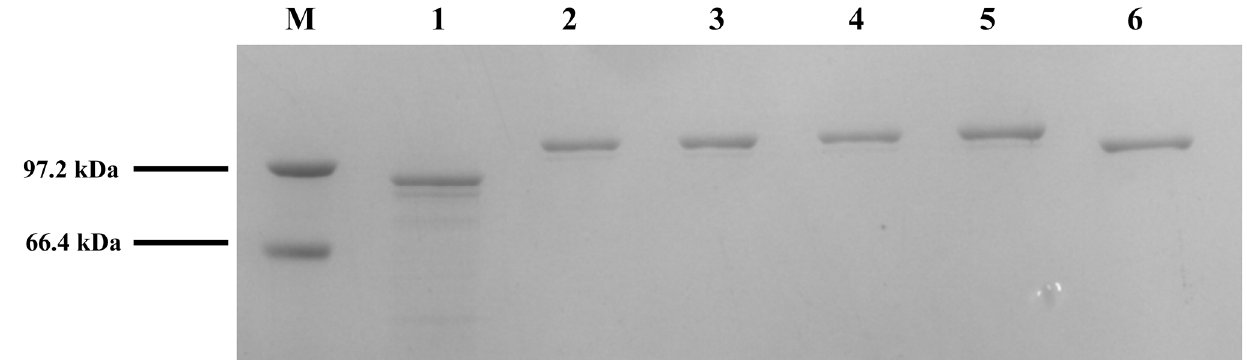
Figure 4. SDS-PAGE analysis of cyclized AGL. Lane M, protein marker; Lane 1, Control (wild type AGL); Lane 2, RIAD-AGL-RIDD; Lane 3, SpyTag-AGL-SpyCatcher; Lane 4, SnoopTag-AGL-SnoopCatcher; Lane 5, SdyTag-AGL-SdyCatcher; Lane 6, linear AGL.